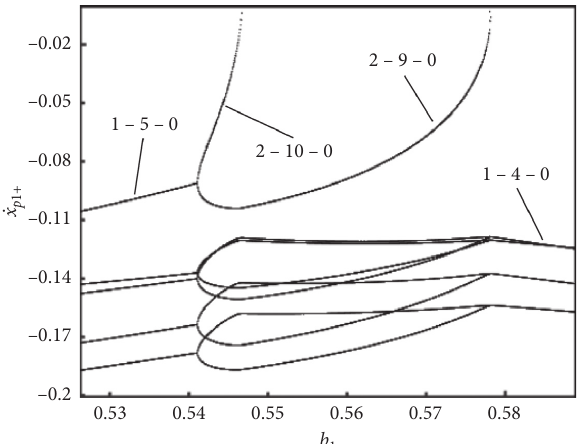
Figure 8: Single-parameter bifurcation diagram at ω � 0 . 2706.